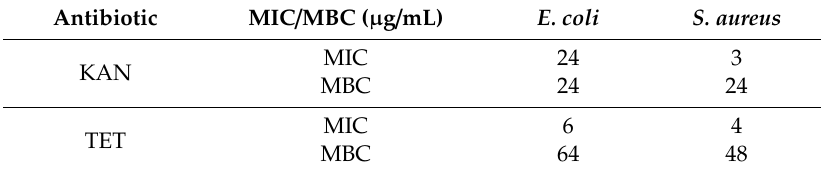
Table 3. MIC and MBC of KAN and TET against E. coli CECT 343 and S. aureus CECT